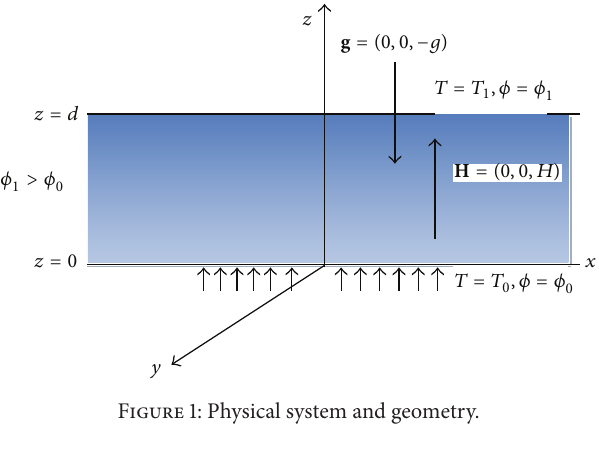
Figure 1: Physical system and